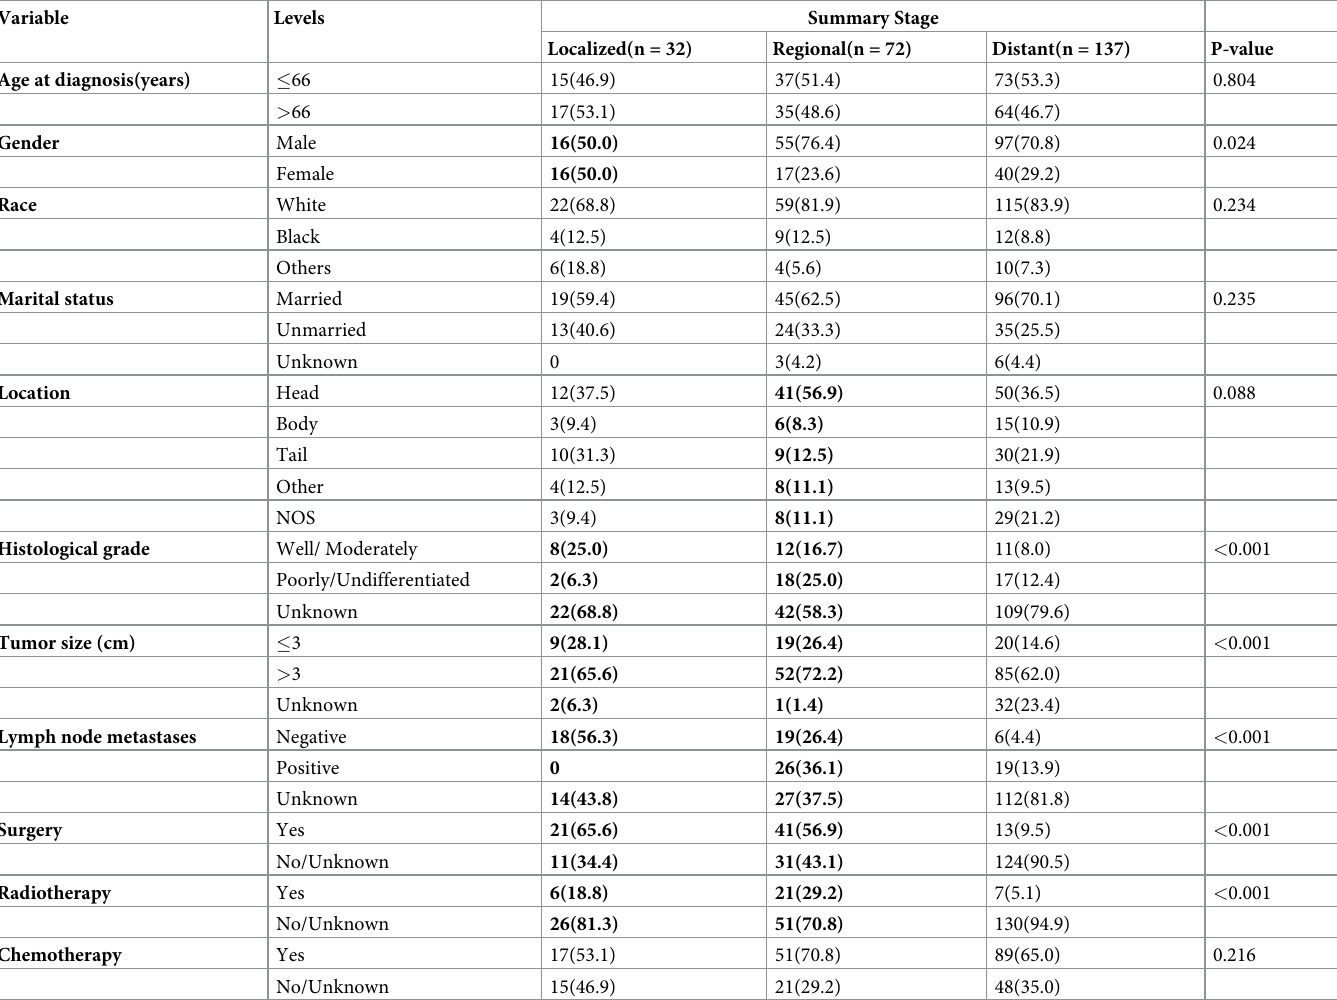
Table 2. The clinical features of the patients with pancreatic acinar cell carcinoma according to stratification by the summary stage. Variable